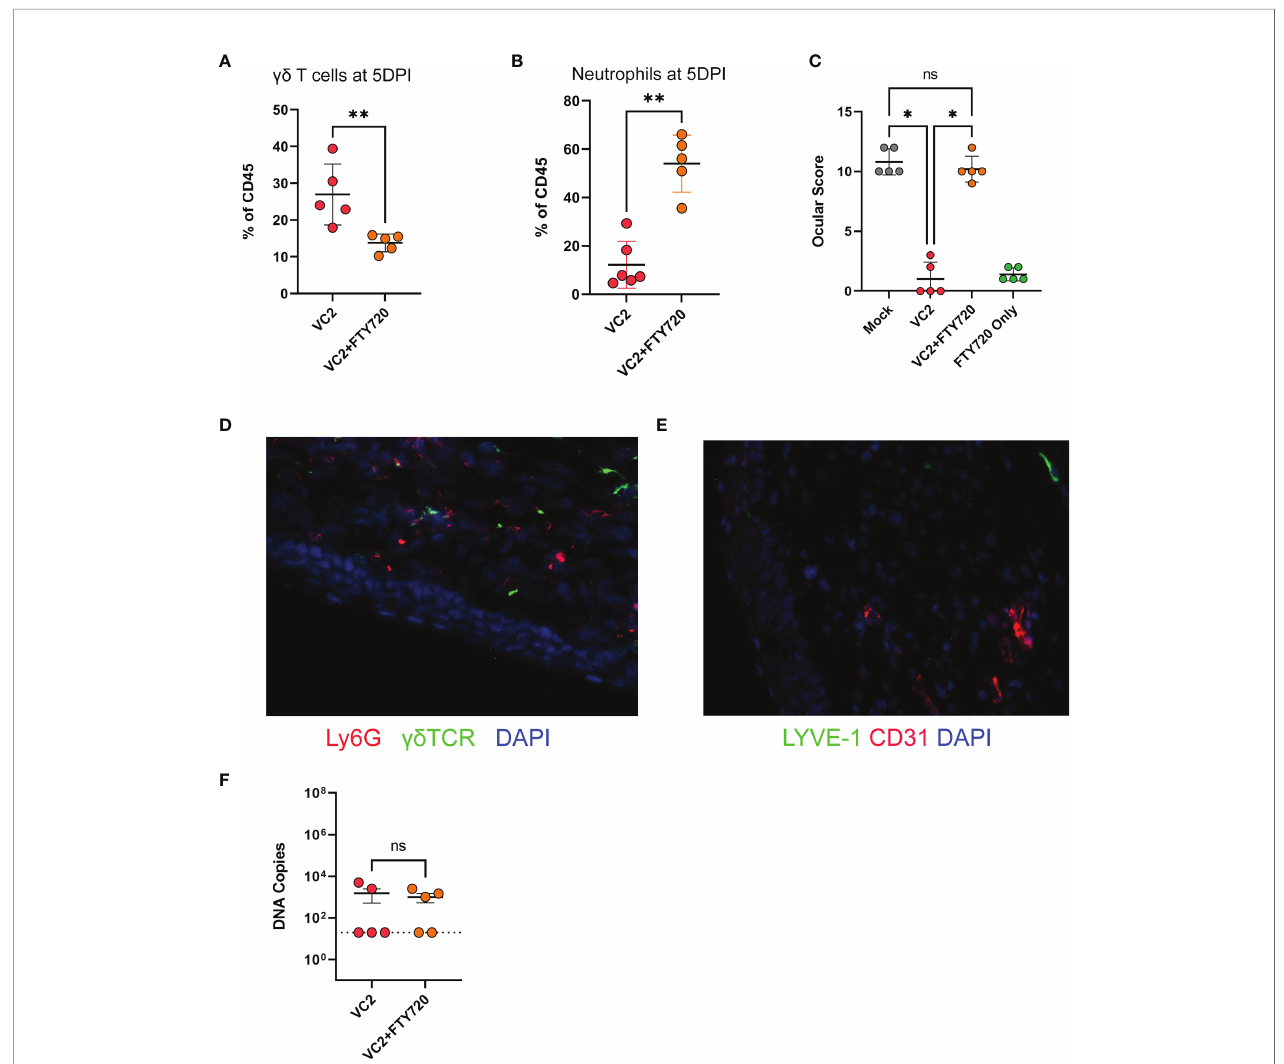
FIGURE 7 | Ocular in fi ltration and score following inhibition of T cell migration. T cell migration in mouse eyes was inhibited by the administration of FTY720 on ocular surfaces. (A) gd T cell in fi ltration. (B) Neutrophil in fi ltration at 5DPI. (C) Ocular score following infection. (D) IFM on a representative OCT section for detection of gd T and neutrophil cell in fi ltration in ocular tissues. (E) IFM for CD31 and LYVE-1 expression. (F) Viral DNA copies in TG using qPCR. *<P=0.05, **<P=0.005 using the Mann-Whitney test, n=5/group. ns, Non-Signi fi